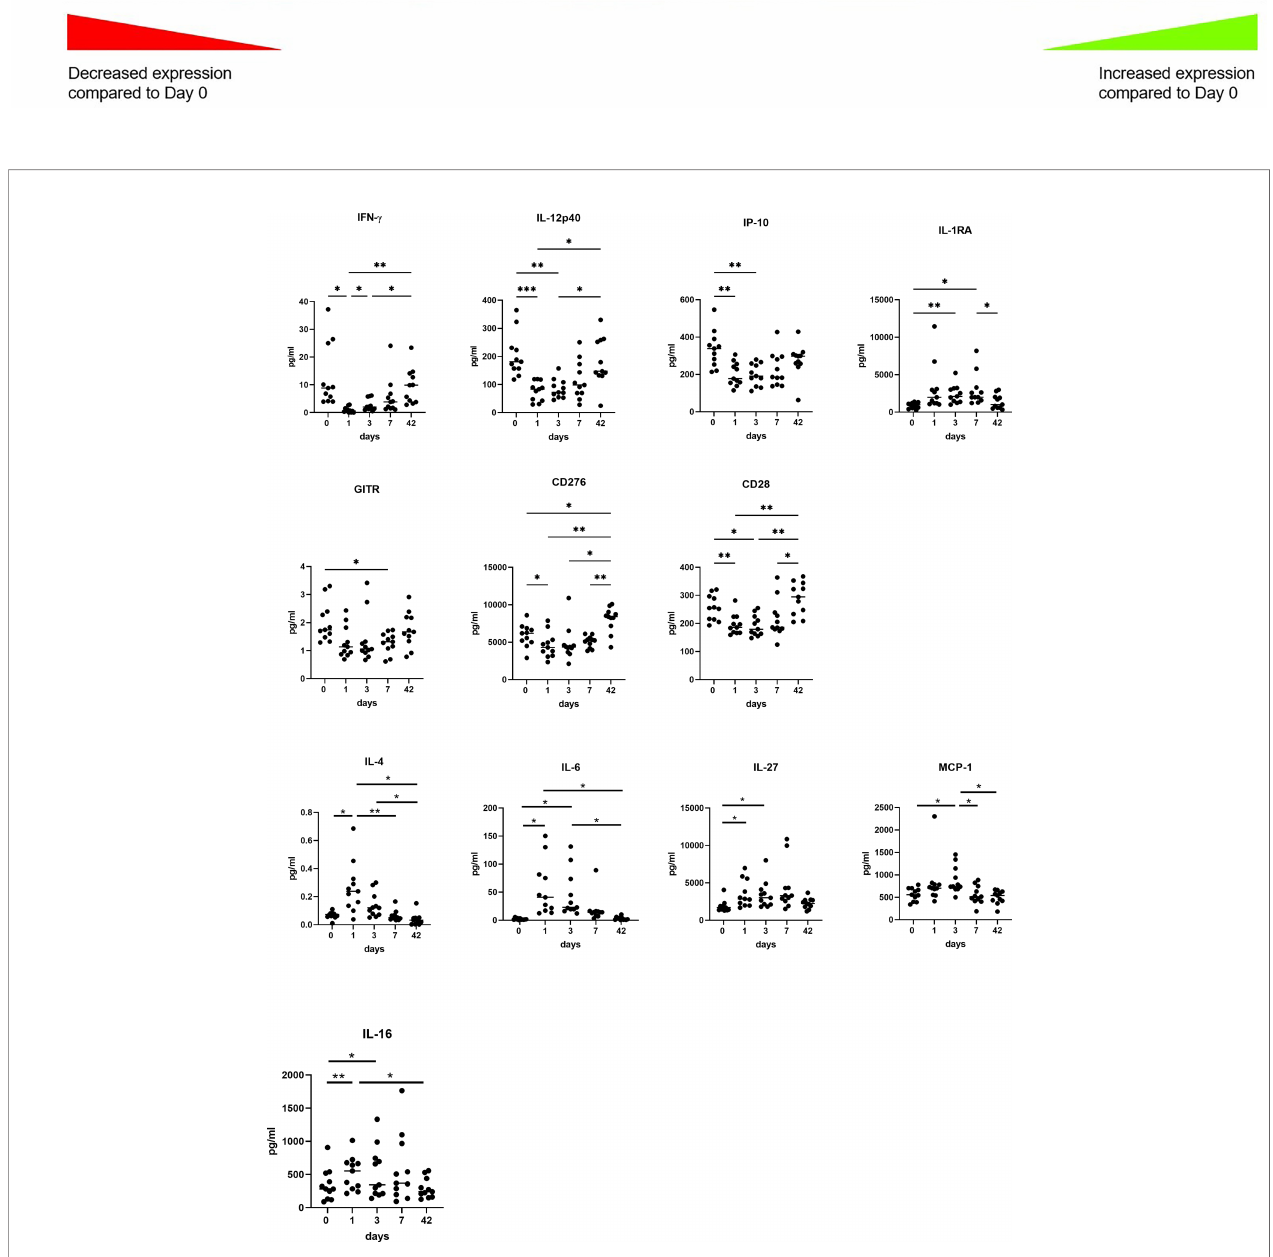
FIGURE 5 | A switch from Th1 to Th2 immunity is observed in systemic circulation in OAC patients in the immediate post-operative setting. Preoperatively, POD 1, 3 and 7 and week 6 serums from OAC patients (n=11) were screened for a panel of soluble Th1 mediators (IFN- g , IL-12 p40, IL-1RA and IP-10) and soluble co- stimulatory molecules (GITR, CD276, CD28), and Th2 mediators (IL-4, IL-6, IL-27) and soluble chemokine ligands and pro-in fl ammatory mediators responsible for promoting pro-tumor immune cells (MCP-1 and IL-16) by ELISA. *p<0.05, **p<0.01,